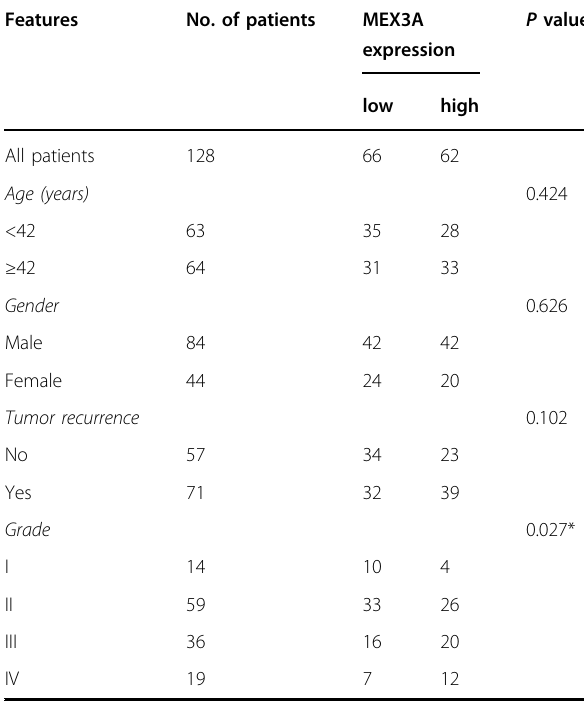
Table 2 Relationship between MEX3A expression and tumor characteristics in patients with glioma.